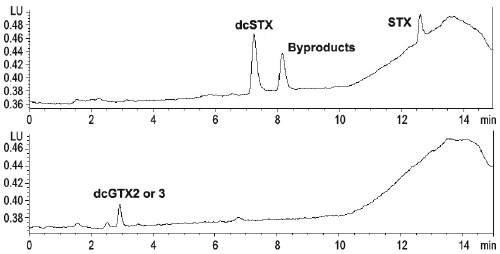
Figure 5. Chromatogram of a) Cylindrospermopsis raci- borskii (IRA02) extract indicating the presence of STX and dcSTX and b) Planktothrix agardhii (IRA07) extract indicating the presence of dcGTX 2 or